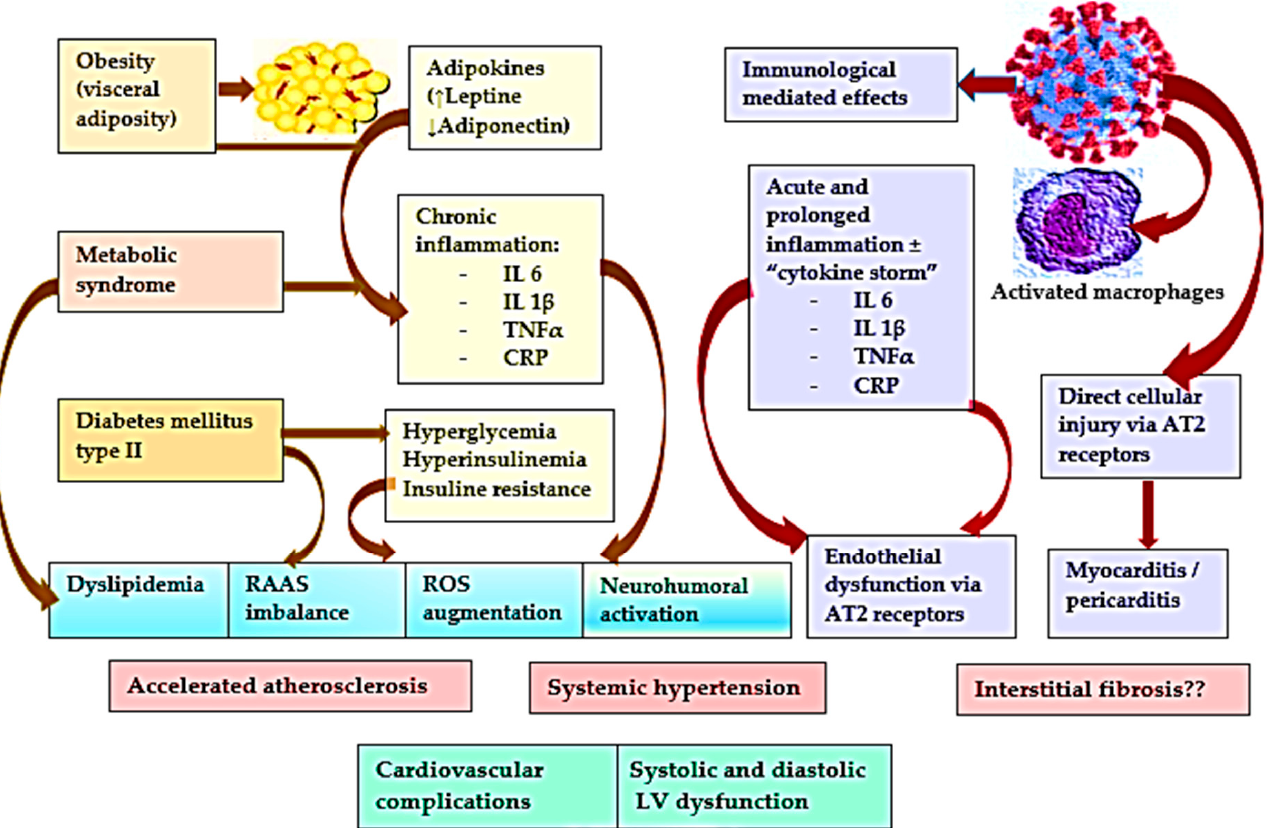
Figure 1. Connections between the pathophysiological processes involved in metabolic dysfunctions and in COVID-19. Legend: IL—interleukin; TNF—tumor necrosis factor; CRP—C reactive protein, AT—angiotensin; RAAS—renin-angiotensin-aldosterone system; ROS—reactive oxygen species.